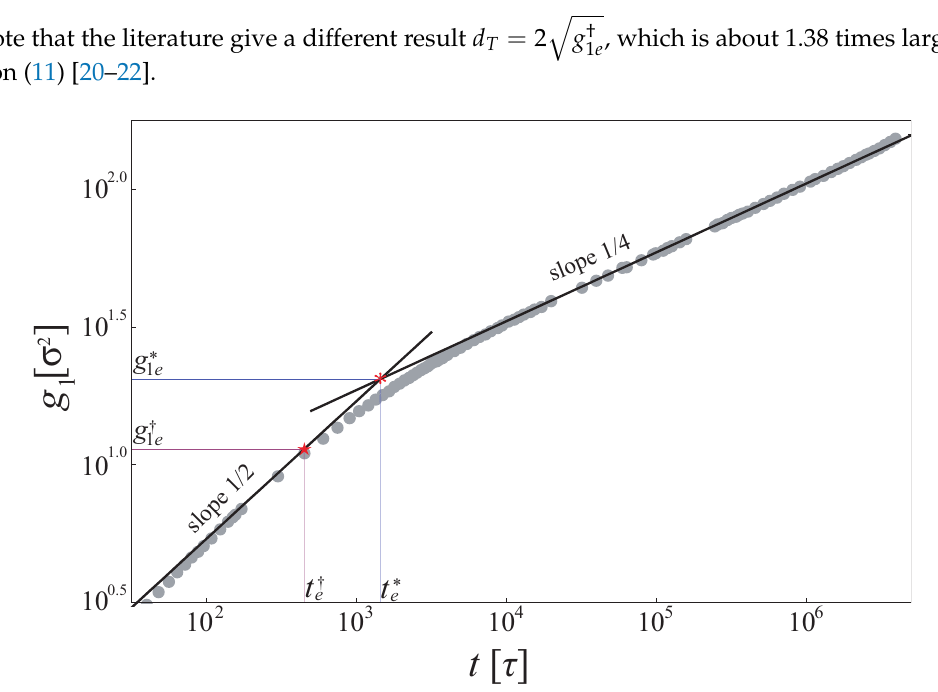
Figure 2. Monomer mean square displacement g 1 ( t ) of the Kremer–Grest model with k θ = 1.5 from Reference [18]. The black solid lines are the best fits to the slope- 1 The red asterisk is the intersection of two straight lines, and the red pentagram denotes the time at which the slope of g 1 ( t ) changes from